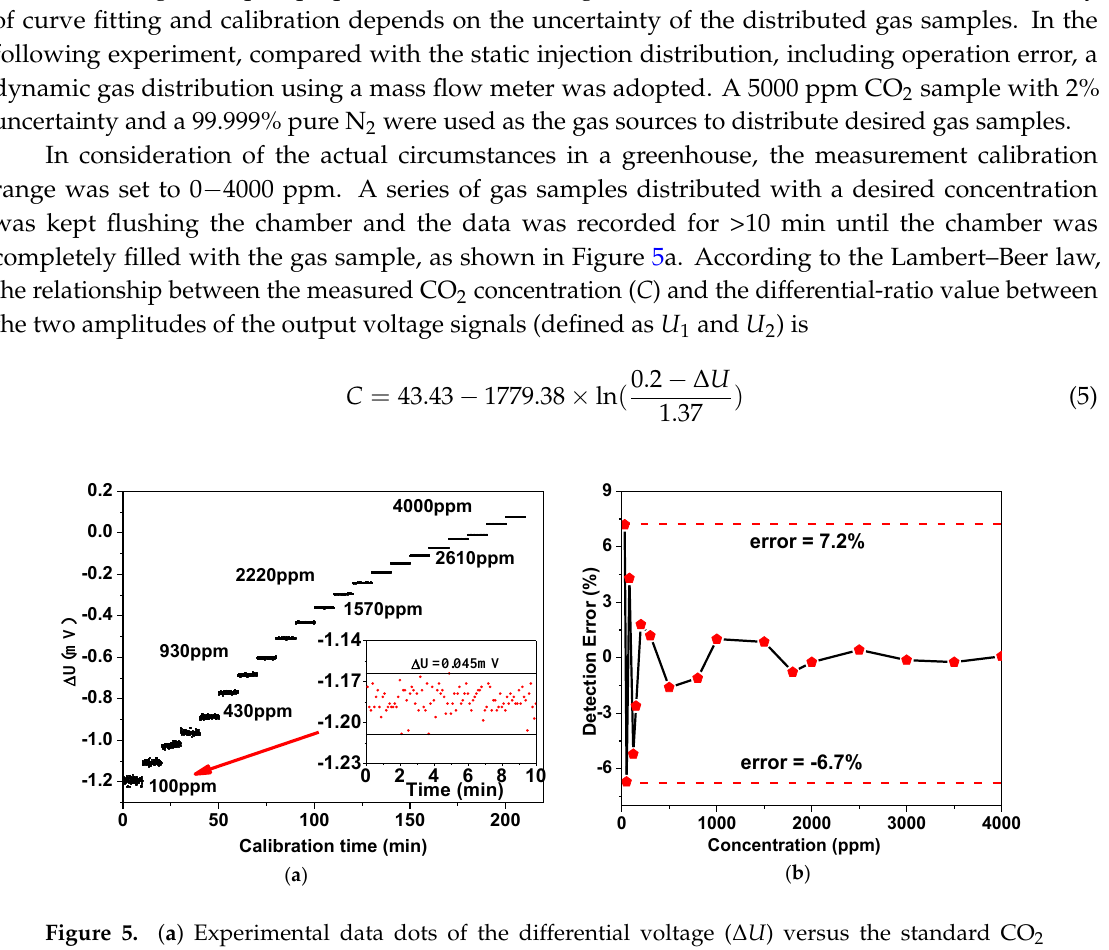
2 concentration regulation.